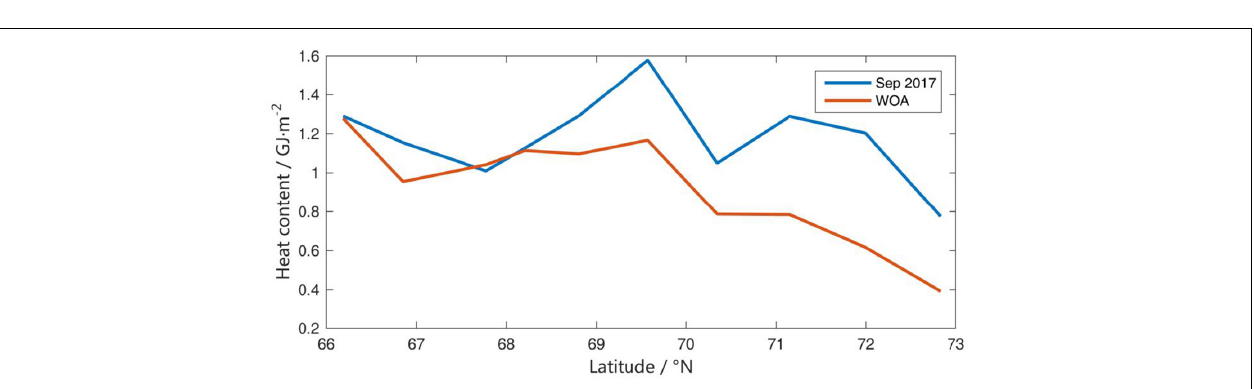
FIGURE 4 | Heat content (in GJ m − 2 ) obtained for the R section using data from the in situ CTD stations and the WOA18 dataset during September